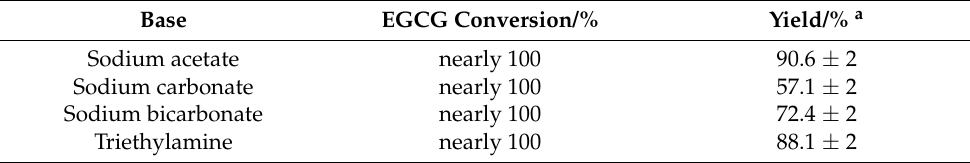
Table 3. Effect of the base on the acylation